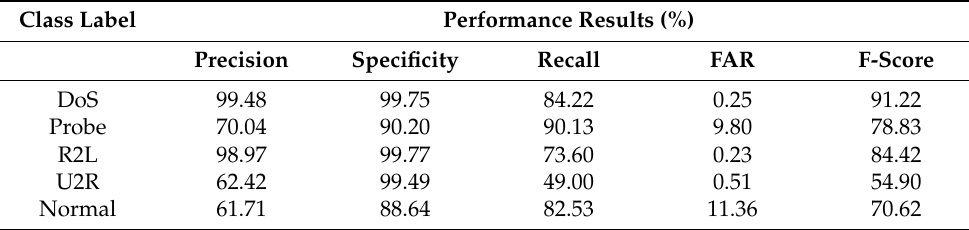
Table 10. BidLSTM performance on NSL-KDDTest − 21 using all 41